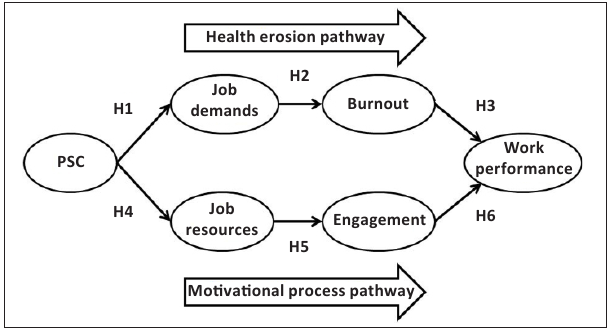
FIGURE 1: Study model - PSC as precursor to job demands and job resources and its relationship to work performance through burnout and